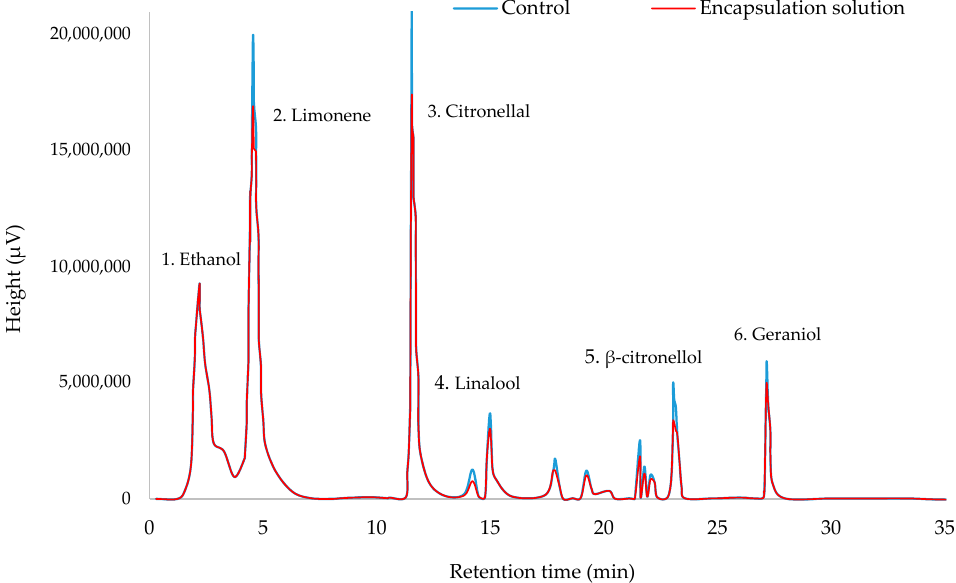
Figure 2. Overlaying of chromatographic analysis of free cinnamon EO (control) and cinnamon EO encapsulated within GD-PPI-3 under optimized conditions—(1) ethanol (sample solvent), (2) linalool, (3) β -caryophyllene, (4) trans-cinnamaldehyde, (5) cinnamyl acetate, (6) eugenol.